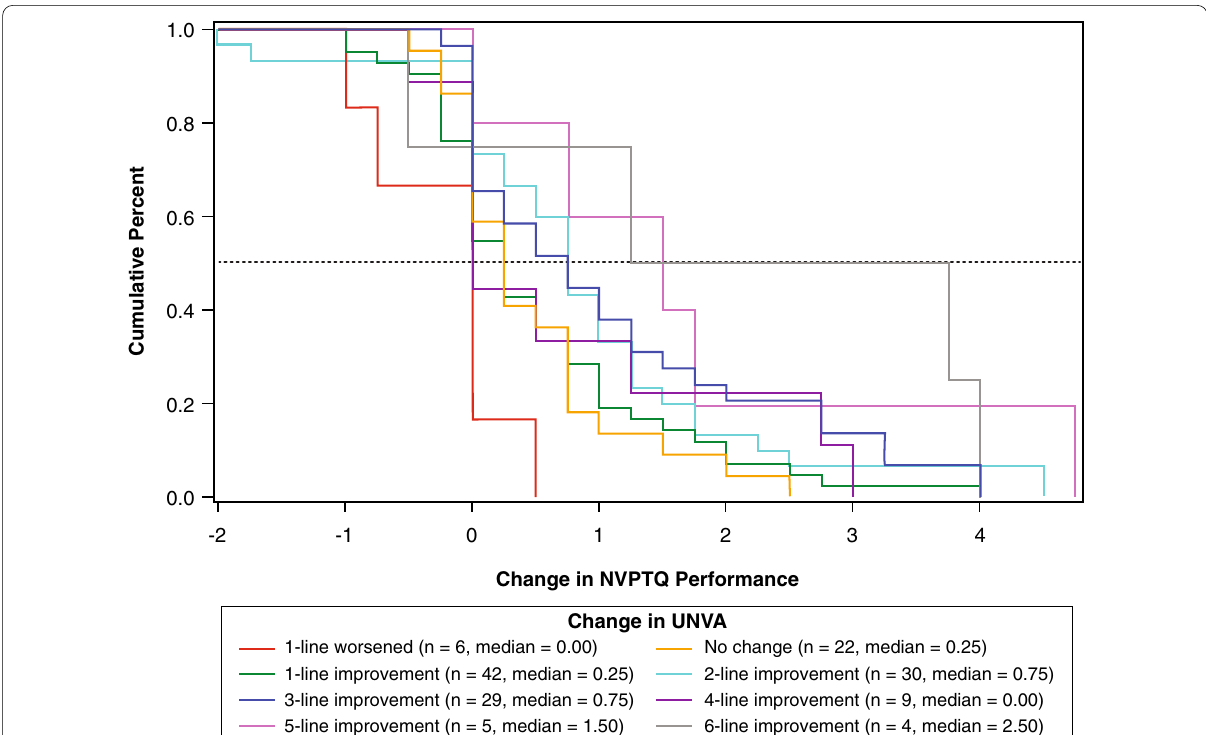
Fig. 7 eCDF of change in NVPTQ Performance by change in UNVA. Note Change is computed as Day 28 Hour 1 minus Day 1 Hour 0. Positive scores indicate improvement. eCDF, empirical cumulative distribution; NVPTQ, Near Vision Presbyopia Task-based Questionnaire; UNVA, uncorrected near visual